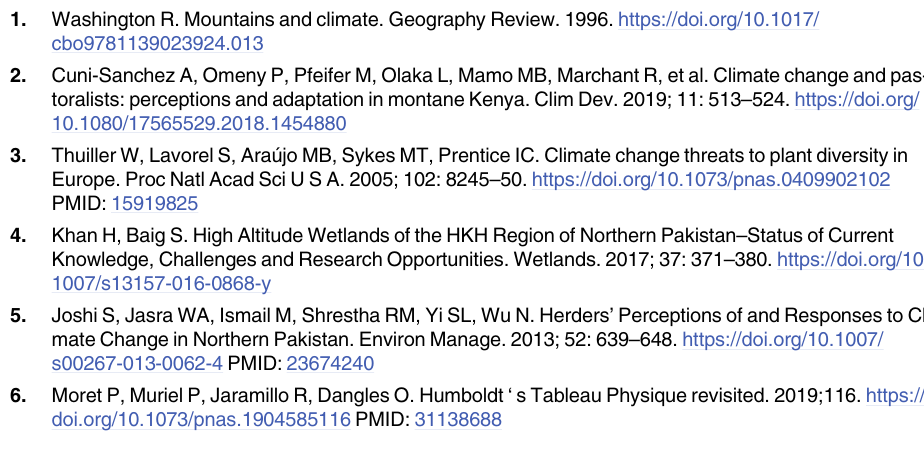
S5 Table. The true data points are attached as excel file in supplementary information.